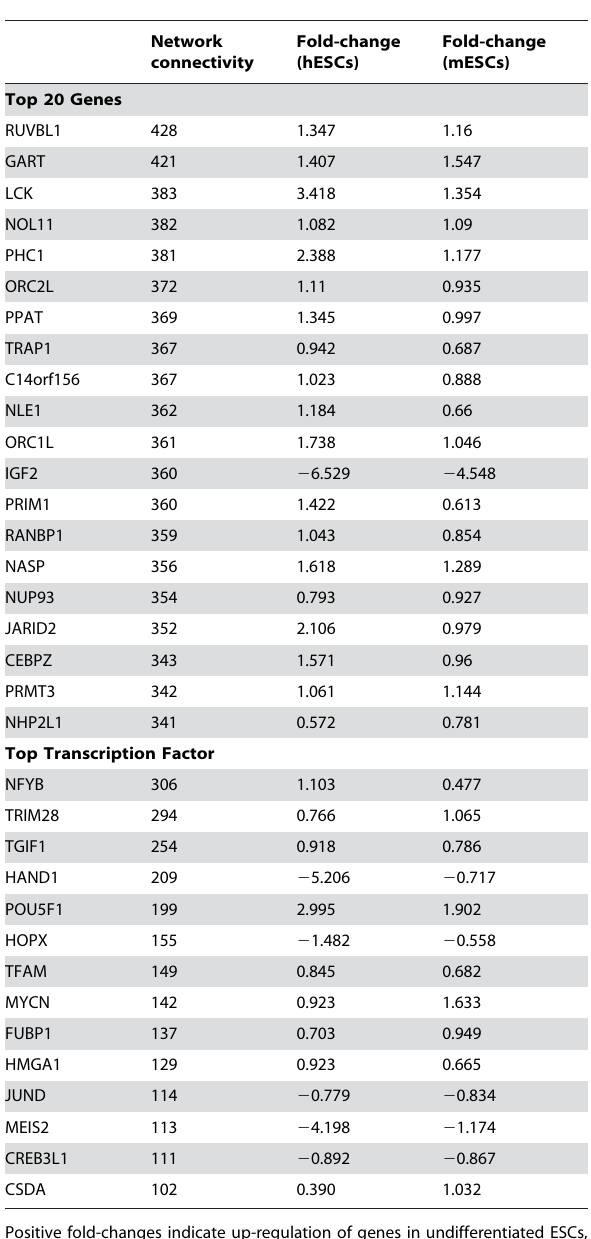
Positive fold-changes indicate up-regulation of genes in undifferentiated ESCs, while negative fold-changes indicate down-regulation. The up- or down- regulation is significant in all the genes in both hESCs and mESCs (adjusted P value # 0.05 by paired t-test). Top 20 hub genes and top transcription factors (connectivity . 100) are listed, respectively.